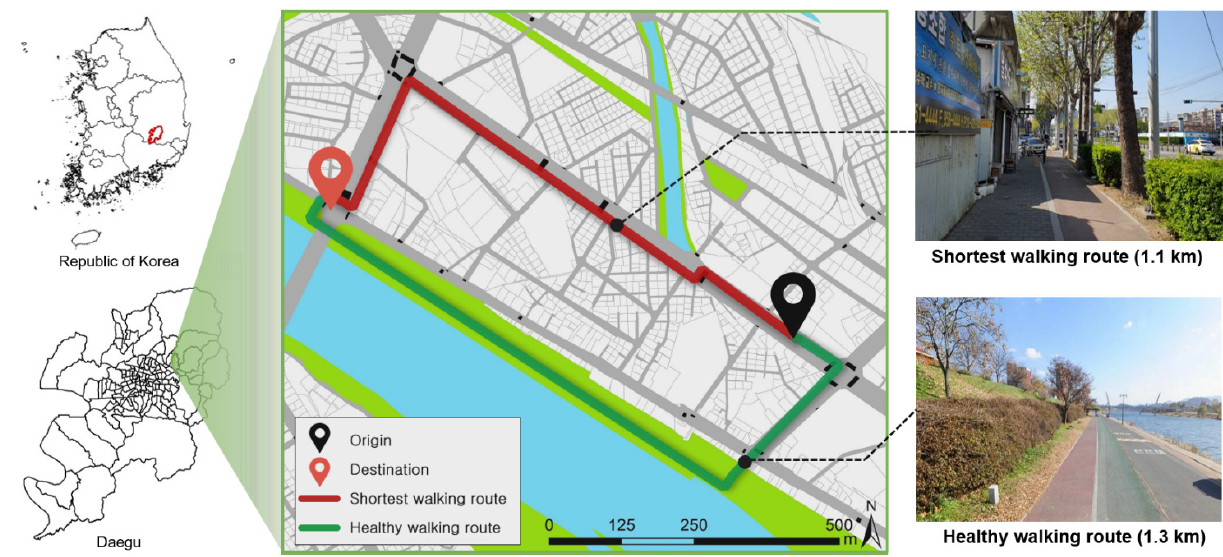
Figure 1. Study area and route setting. leisure purposes. Satisfaction with the selected walking route was measured on a scale of 1 to 10